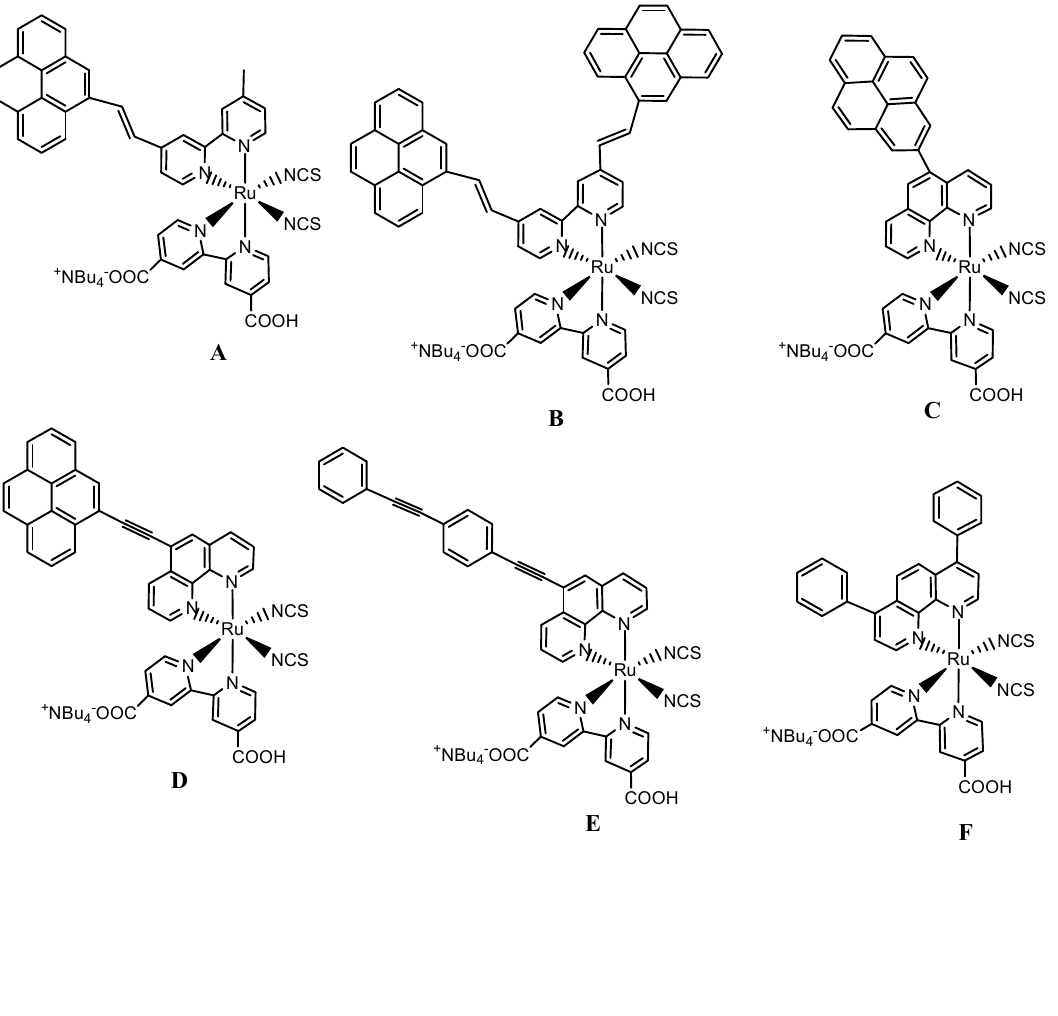
Figure 6. Representative structures of [Ru(bpy)